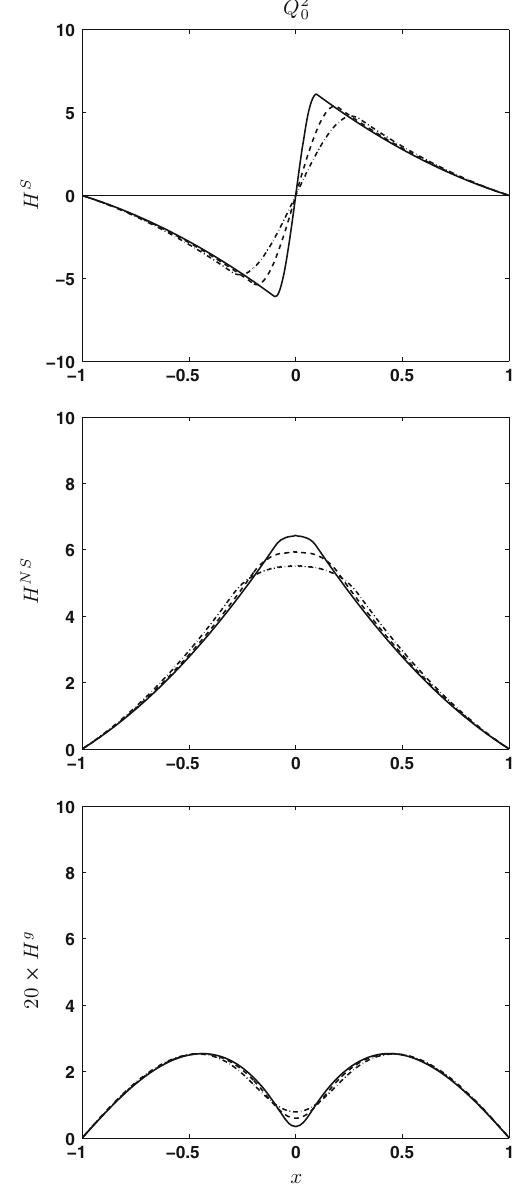
Fig. 10 The soft-wall predictions for GPDs. Singlet-quark ( upper panel ),non-singlet-quark( middlepanel )andgluon(amplified20times, lower panel ) GPDs at the low momentum scale Q 2 and (37)] at t = − (cid:3) 2 = 0, using the DDs (43). Full lines for ξ = 0 . 1, dashed lines for ξ = 0 . 2 and dot-dashed lines for ξ = 0 .